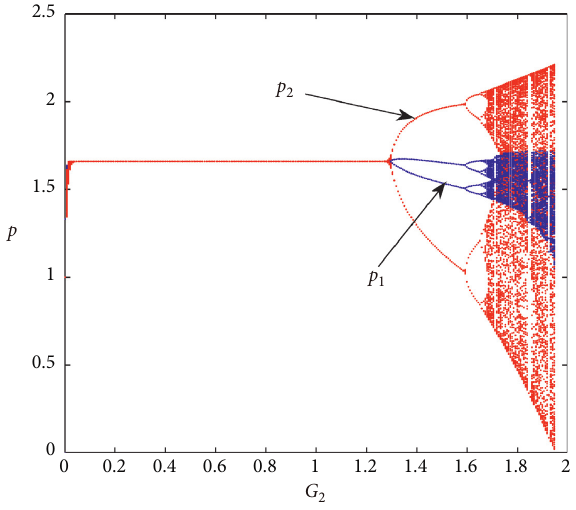
Figure 2: Price bifurcation diagram.